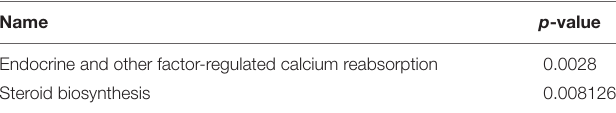
TABLE 3 | KEGG pathways affected by heat